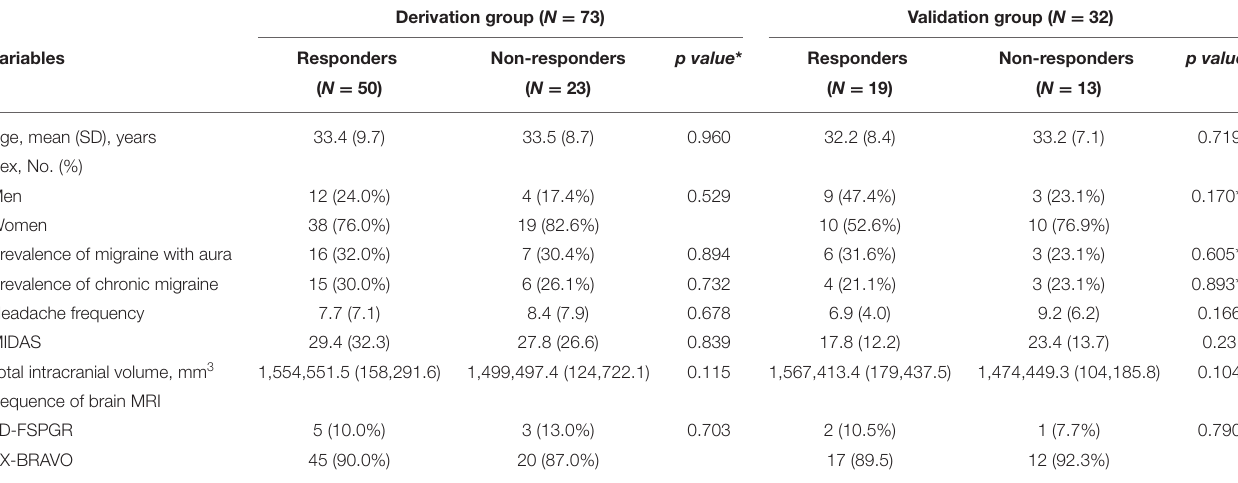
TABLE 2 | Demographics and clinical profiles of responders and non-responders in the derivation and validation